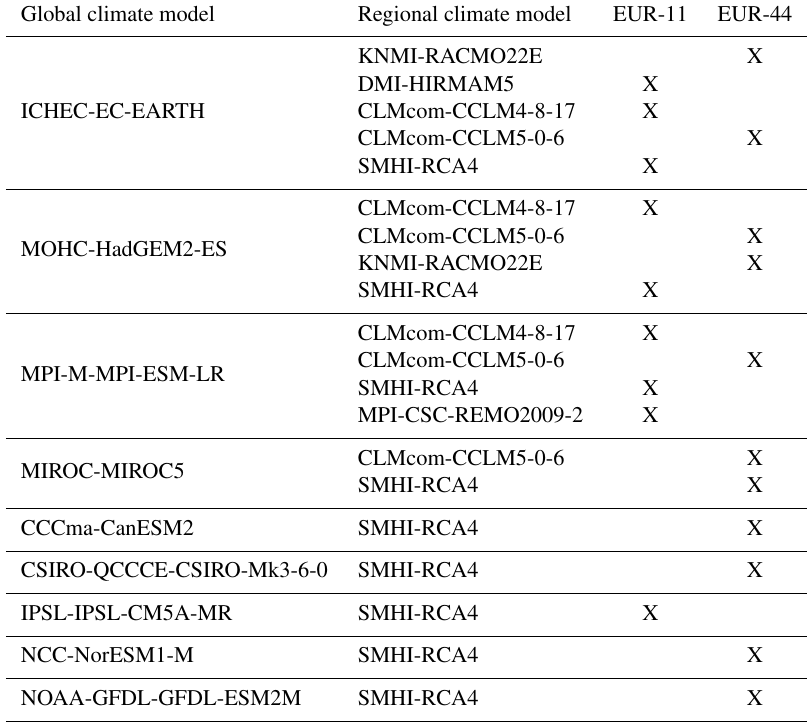
Table 1. Overview of the climate model chains available and their initial grid spacings of 12km (EUR-11) and 50km (EUR-44). Global climate model Regional climate model EUR-11